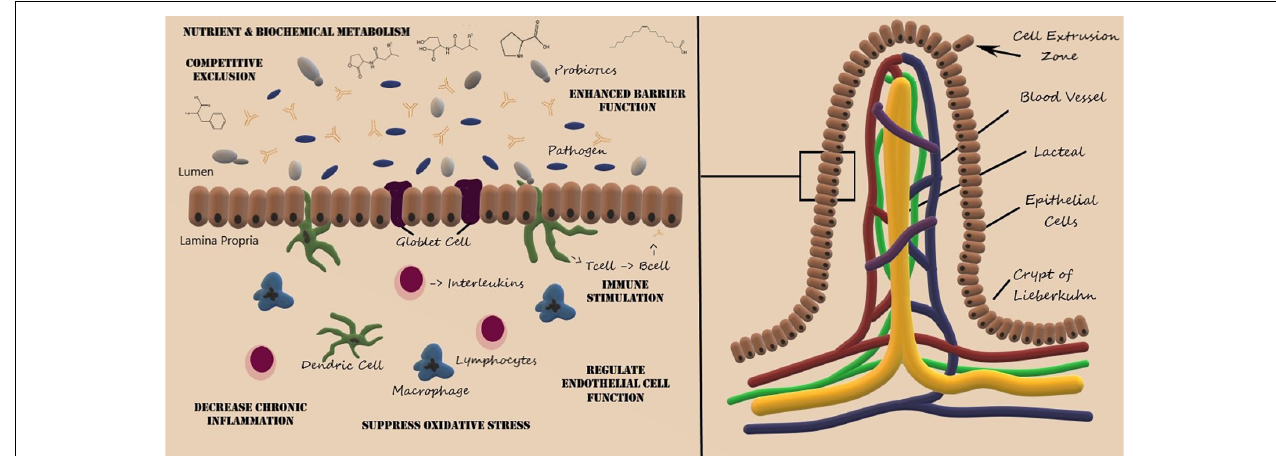
FIGURE 1 | Structure of the villus of the small intestine and representative probiotic mechanisms of action. Artwork by Audrey Milner.